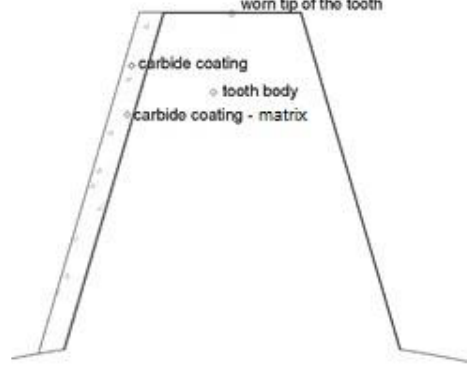
Figure 13. Display of measurement positions of micro hardness tests on the